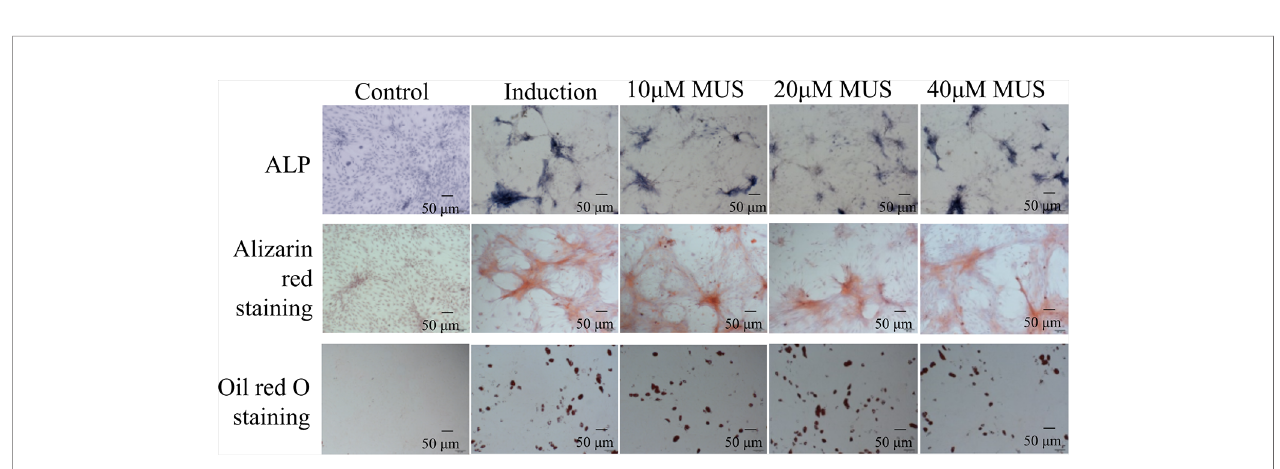
FIGURE 3 | Muscone has limited impact on BMSCs differentiation. Alkaline phosphatase (ALP) staining and alizarin red (ARS) staining show that muscone at 10 m M, 20 m M, and 40 m M has little in fl uence on the mineralization of calcium nodules. And the oil red O staining shows that muscone has little consequence on the formation of fat particles in vitro .